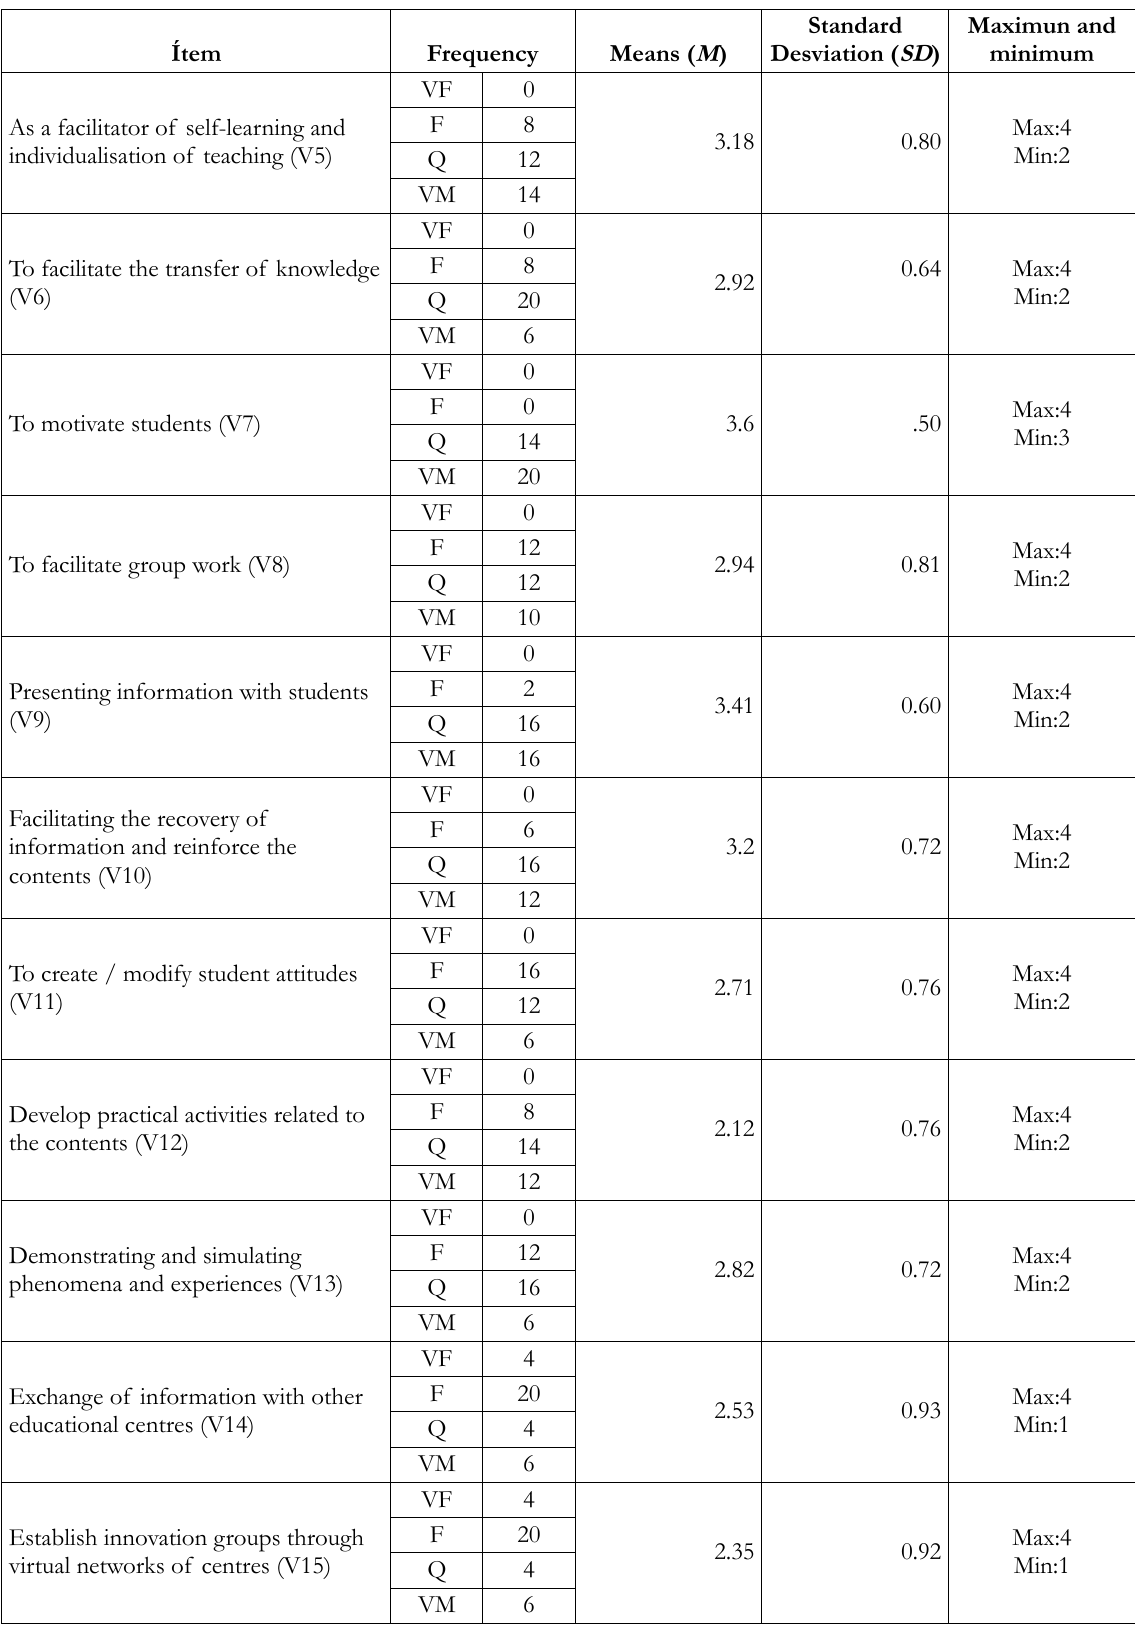
Table 4. Dimension values linked to the use of ICT by teachers in their classroom